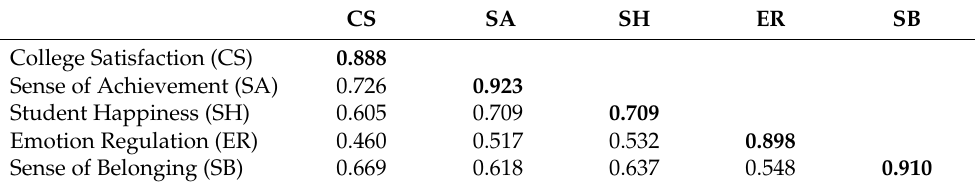
Table 2. The square root of AVE and bivariate correlations between the constructs.